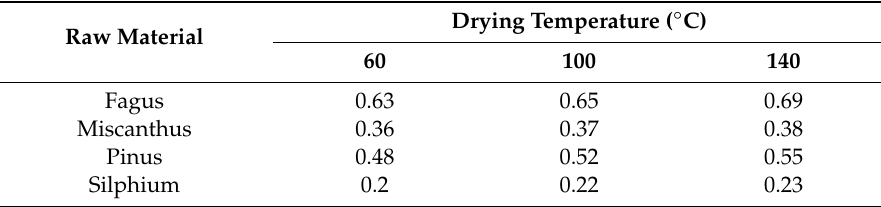
Figure 10. Packing density ϕ changes in the material before and after grinding; R is the initial material, B is the hammer, and N is the knife grinding system. Table 3. Raw material specific density DE (g / cm 3